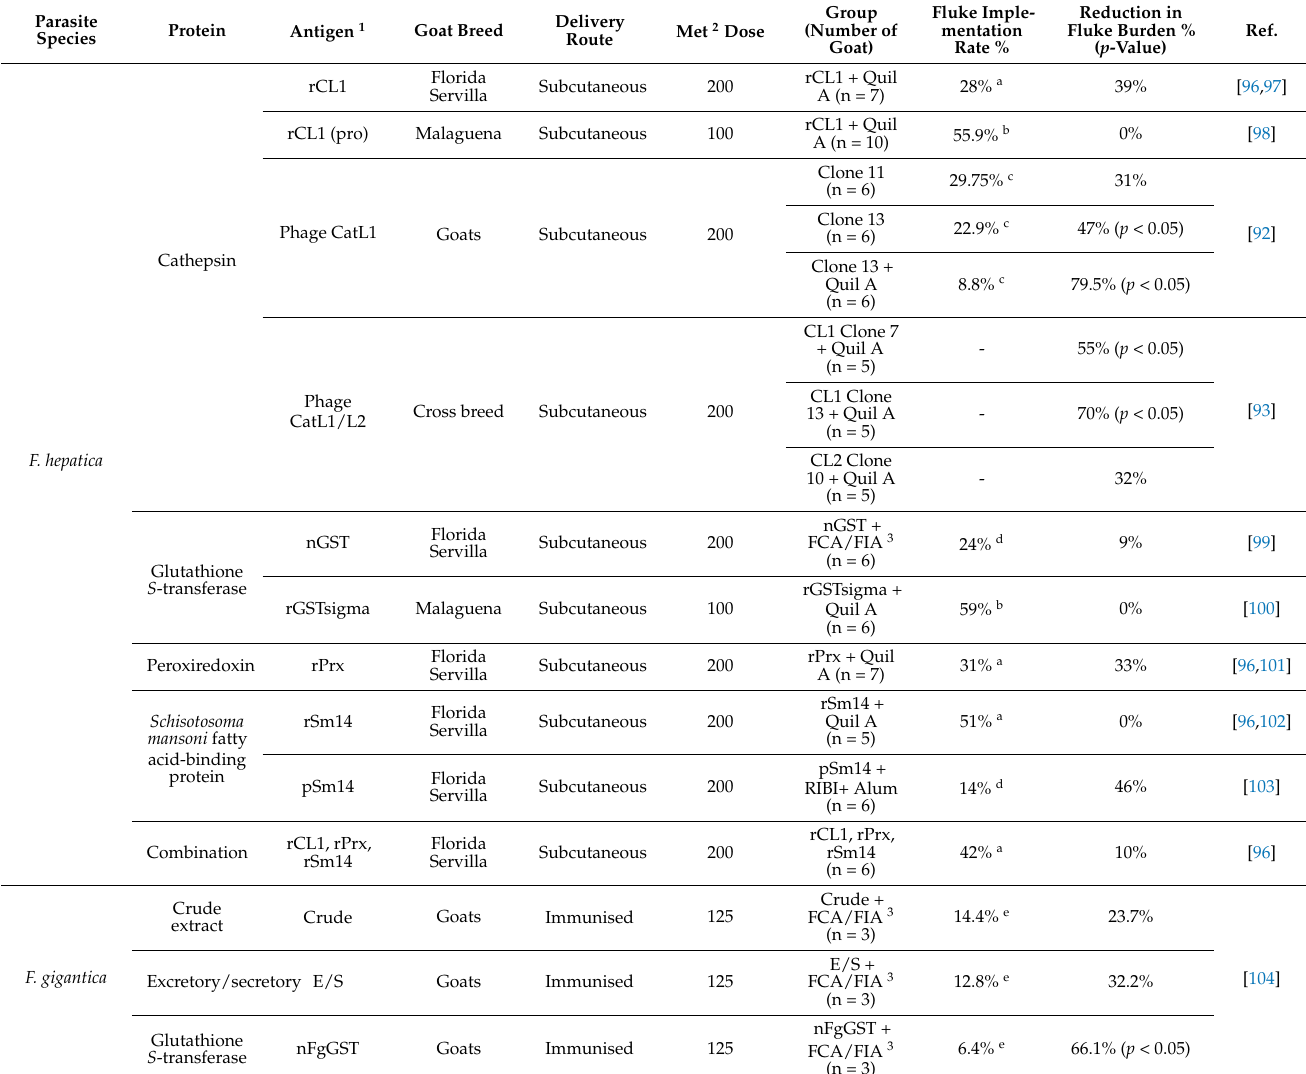
Table 2. Vaccine antigen protection levels in